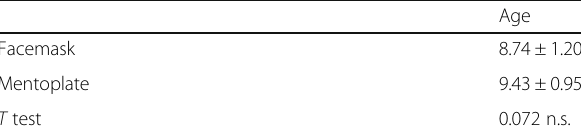
Table 2 Age distribution